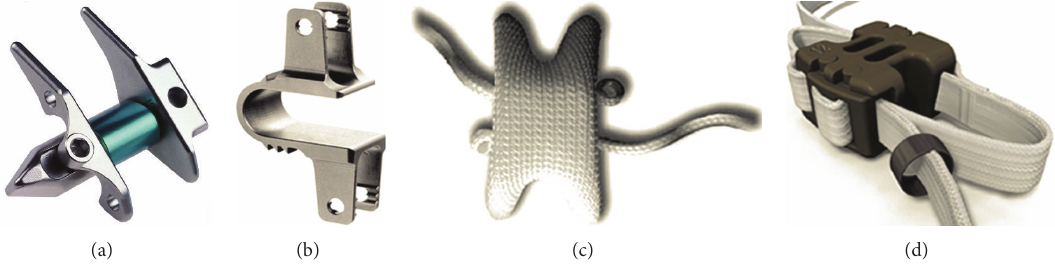
Figure 3: Interspinous spacer: (a) X-STOP, (b) Coflex, (c) DIAM system, and (d) Wallis